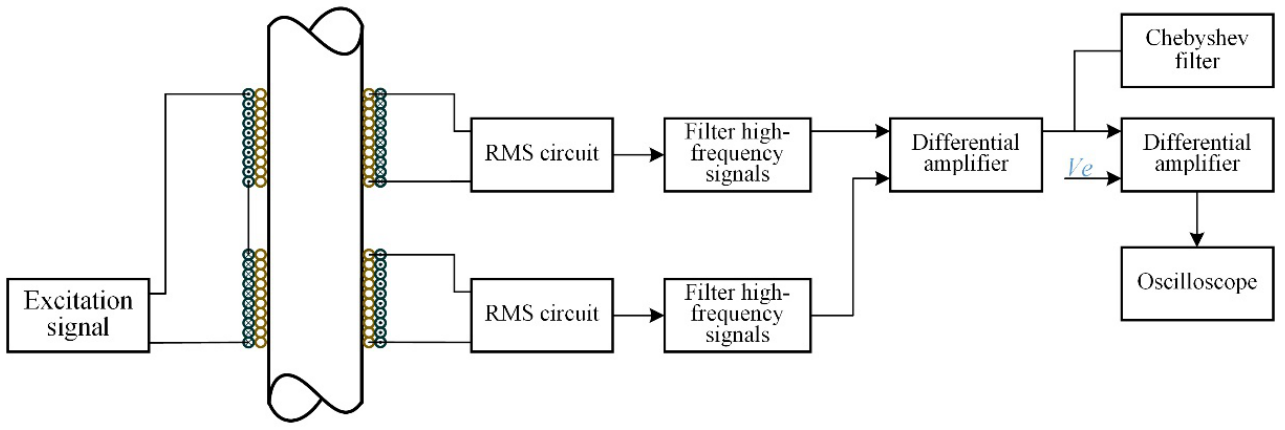
Figure 5. Sensor signal acquisition and processing system.